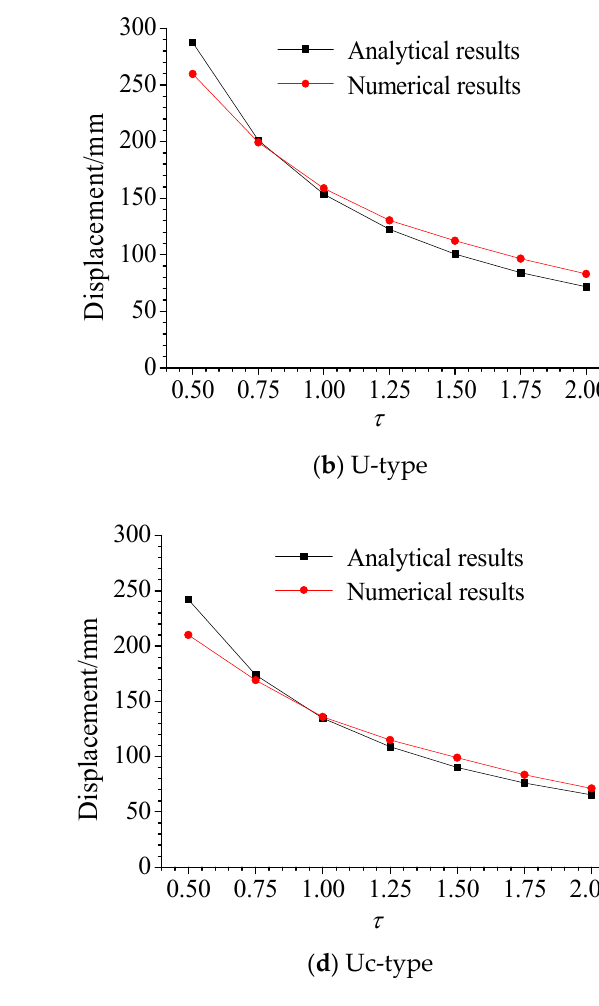
Figure 15. Displacement curves of the sandwich structure with different panel thicknesses ( τ is the ratio of the thickness of the face sheet to the thickness of the core).